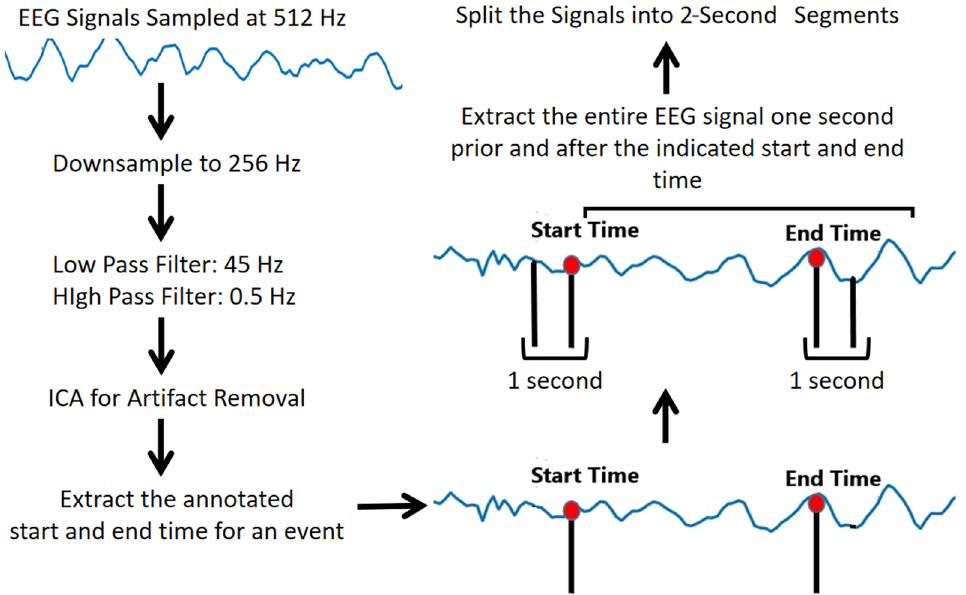
Figure 2. Steps followed for pre-processing the collected EEG